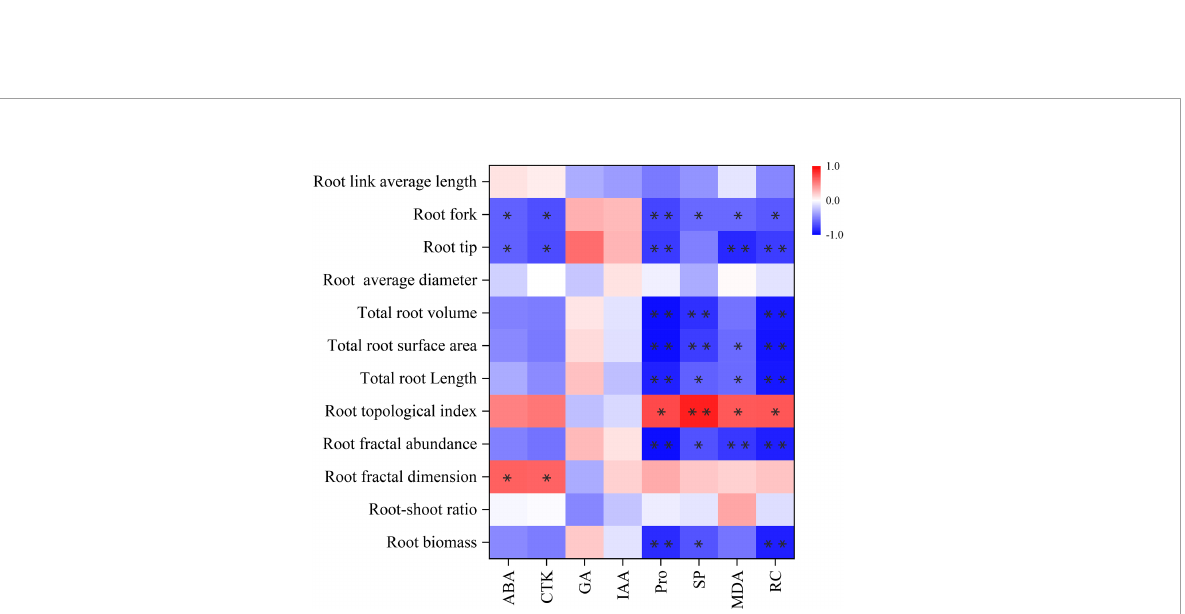
FIGURE 7 Correlation between root physiology and architecture. Each experiment was repeated four times. Signi fi cant correlation between root physiology and architecture are indicated by one asterisk (* P <0.05) or two asterisk (** P <0.01), as determined by Bivariate Pearson correlation